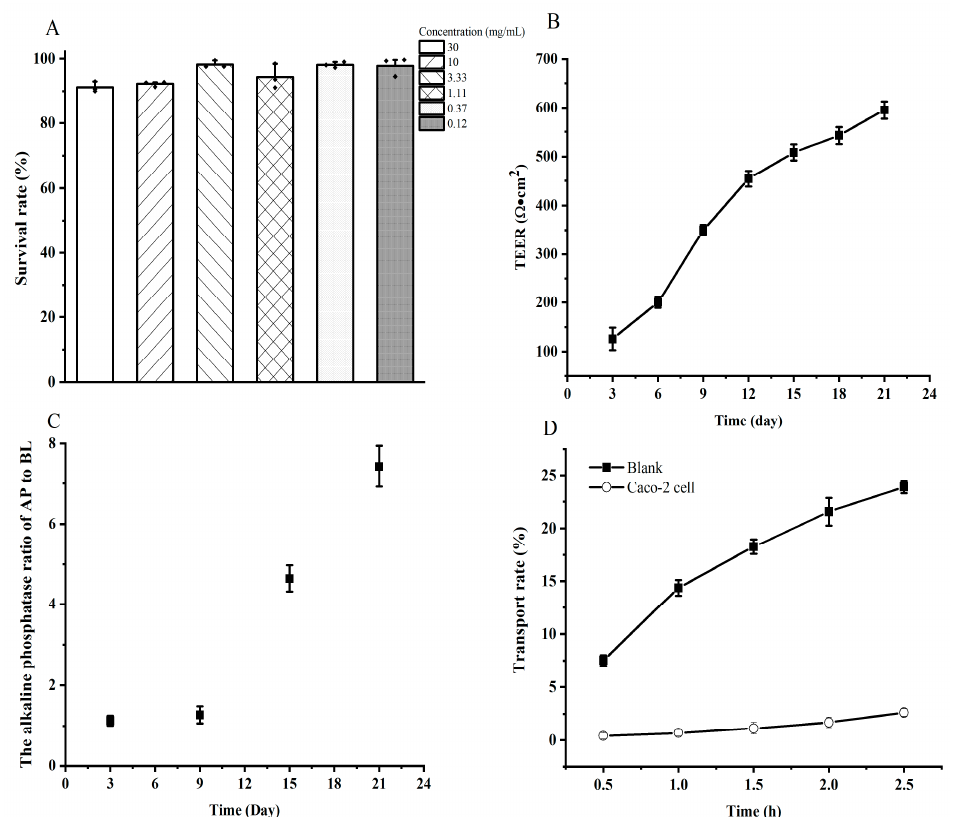
Figure 3. The cell toxicity and cell integrity assessment before transport study. The cell toxicity of different concentrations of digested yak bone collagen hydrolysates ( A ); The transepithelial electrical resistance (TEER) value of Caco-2 cell monolayers ( B ); The alkaline phosphatase (ALP) activity of cell culture medium on the two sides of the transwell ( C ); The permeability of fluorescein sodium on Caco-2 cell monolayers ( D ).